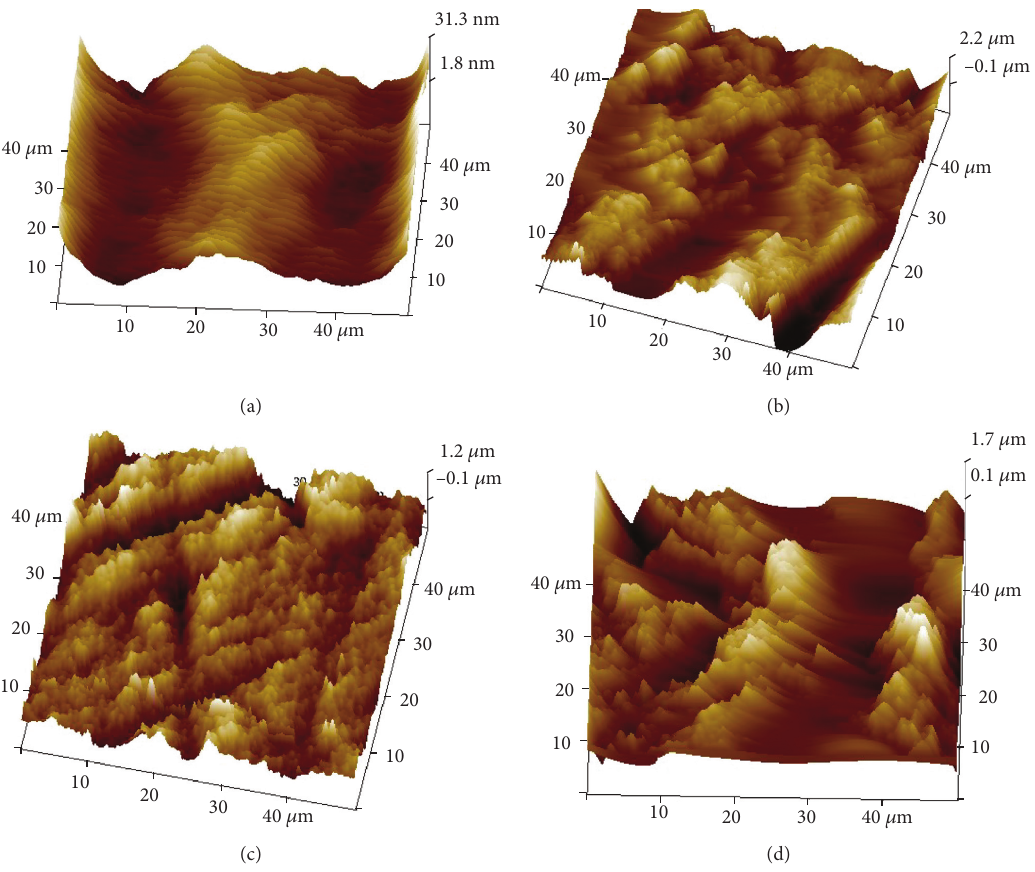
Figure 7: AFM images. (a) Group TC, (b) Group TA, (c) Group TE, and (d) Group TAE. Table 5: AFM roughness values for all groups at 50 µ m in nanometers.